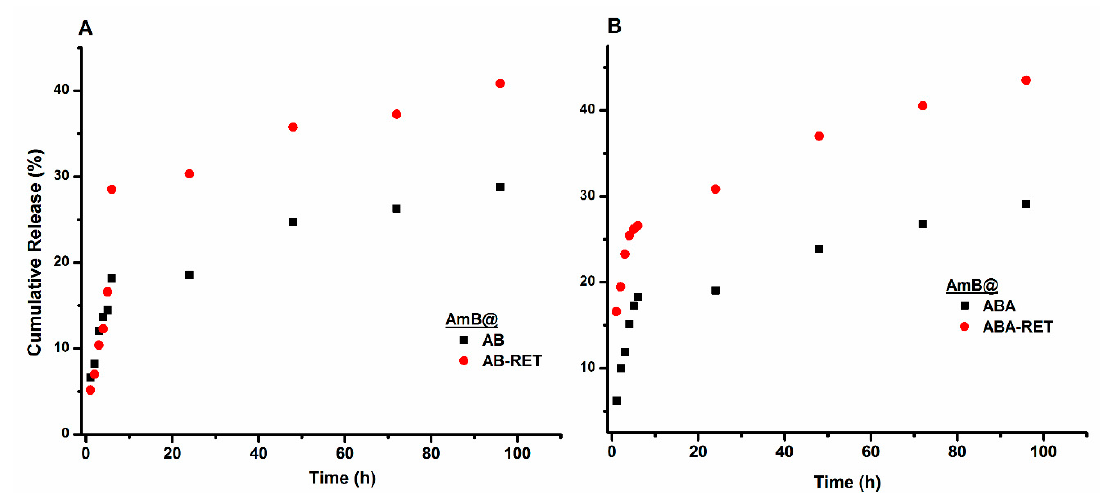
Figure 6. Release profiles of AmB loaded in AB ( A ) and ABA ( B ) and their corresponding conjugates with RET.